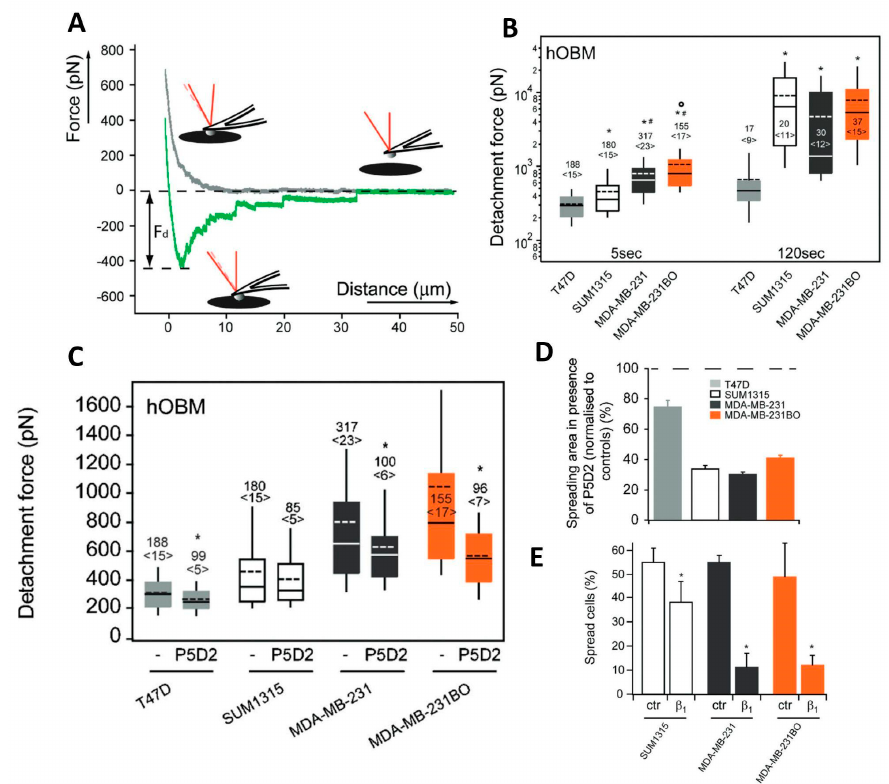
Figure 6. ( A ) Representation of the cell adhesion experiment. The grey line is the approach part of the F-D curve, while the green one is the retraction part. Starting far above the sample (right part of the curve, grey line) the cell was moved downwards and pushed on the substrate. After a defined contact time, the cell was retracted (green line), and the detachment from the adhesive substrate (hOBM or COL I) was registered. F d is the detachment force, i.e., the maximum traction force reached before the detachment process started. ( B ) Detachment forces of BCa cells on hOBM for contact times of 5 s and 120 s. Numbers indicate the total of analyzed F-D curves, the number of probed cells is indicated in parentheses. Top and bottom of the boxes indicate the 75th and 25th percentiles, and upper and lower whiskers the 90th and 10th percentiles. Solid lines within boxes denote the median, and dotted lines denote mean detachment forces. Statistical differences among cells were verified using Kruskal-Wallis tests. Contrasts were calculated for the individual pairs. Significant differences ( p < 0.05) among pairs are indicated as follows: *, any-T47D; #, any–SUM1315; ◦ , MDA-MB-231–MDA-MB-231BO. ( C ) Detachment forces of BCa cells on hOBM in presence of 6 µ g/mL β 1-integrin function-blocking antibody (P5D2). Top and bottom of the boxes indicate the 75th and 25th percentiles, and upper and lower whiskers the 90th and 10th percentiles. Solid lines within boxes denote median, and dotted lines denote mean detachment forces. Results obtained in the presence or absence of the blocking antibody were compared employing a nonparametric Mann-Whitney test. Significant differences ( p < 0.05) among pairs are indicated by *. Numbers of analyzed curves/probed cells are given as in ( B ). ( D ) Mean spreading area (average ± standard deviation) of cells treated with P5D2 normalized to control cells. At least 90 cells were considered for each cell type and condition. ( E ) Spreading of β 1-integrin knockdown cells and control cells (percentage of spread cells) evaluated after 6 h of incubation on hOBM. Data sets of control and β 1-integrin knockdown cells were compared using a t test. Significant differences ( p < 0.05) among pairs are indicated by *. Reprinted with permission from Ref. [108]. 2013, J. Bone Miner.